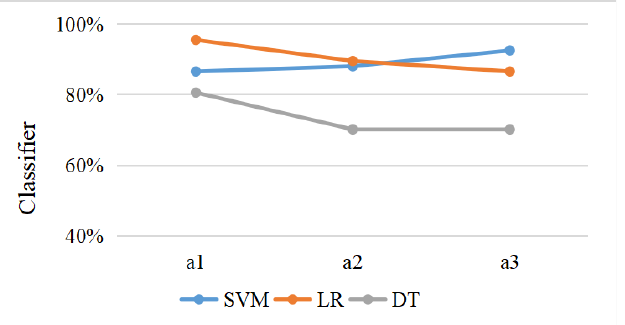
Figure 8. Changes in the accuracy of machine learning algorithms SVM, LR and DT over the course of periods a1, a2, and a3.